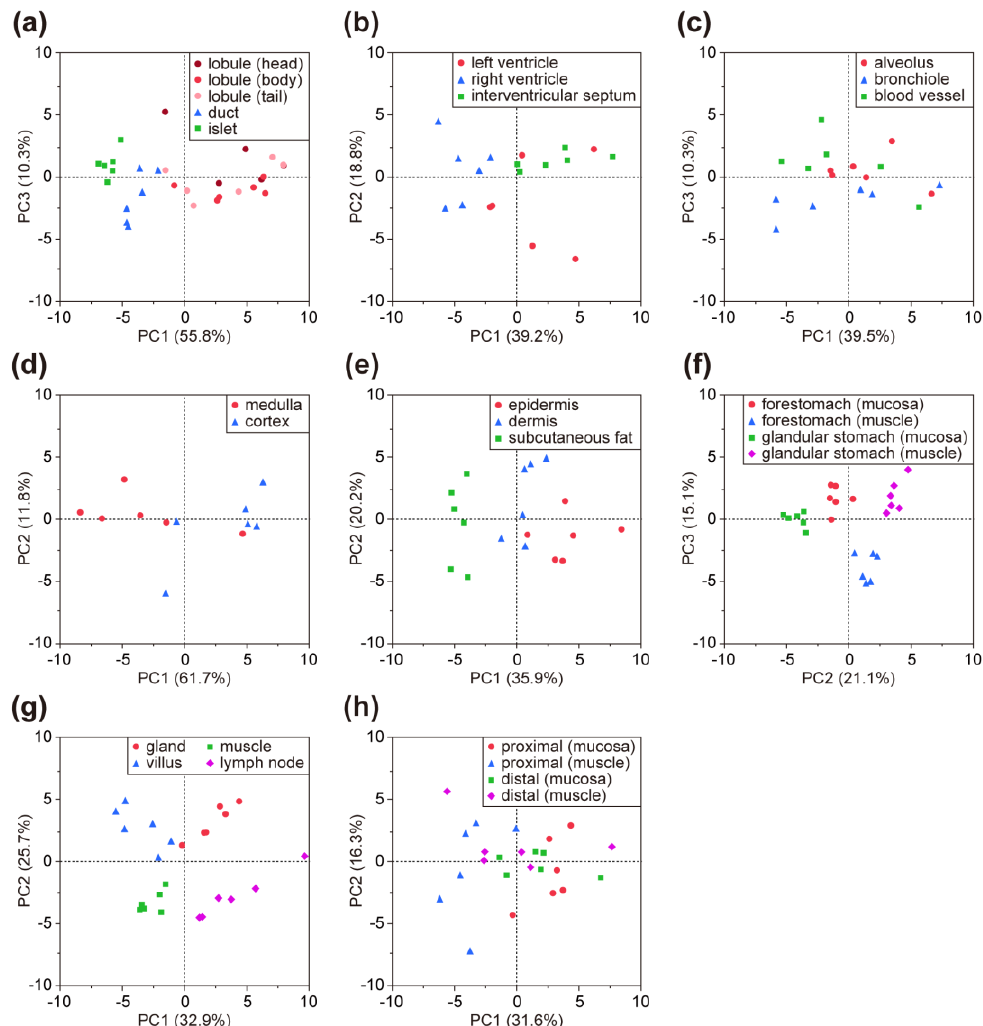
Figure 4. PCA score plots for eight tissues: ( a ) pancreas, ( b ) heart (transverse section), ( c ) lung, ( d ) thymus, ( e ) skin, ( f ) stomach, ( g ) small intestine (ileum), and ( h ) colon. The region/sub-region names and number of the data correspond to those in the sample lists shown in Table 1.